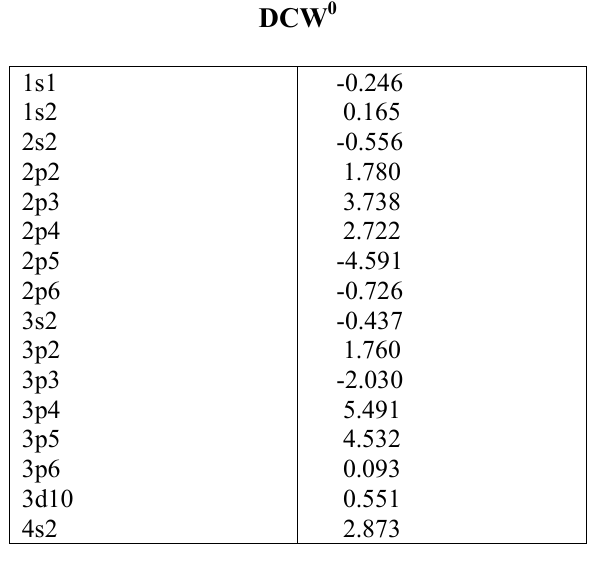
Table 1 . Correlation weights for calculating DCW 0 and DCW